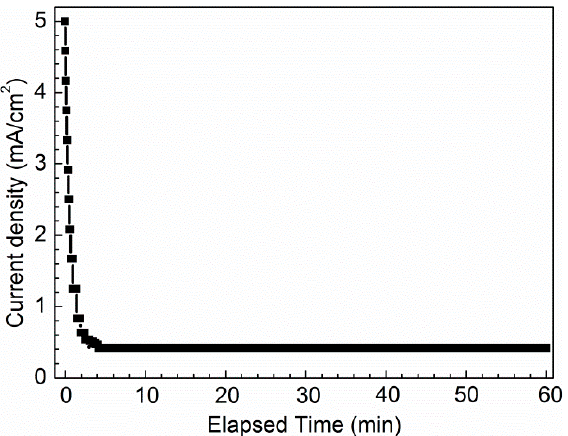
Figure 2. Current density as a function of time recorded during the electrodeposition process.